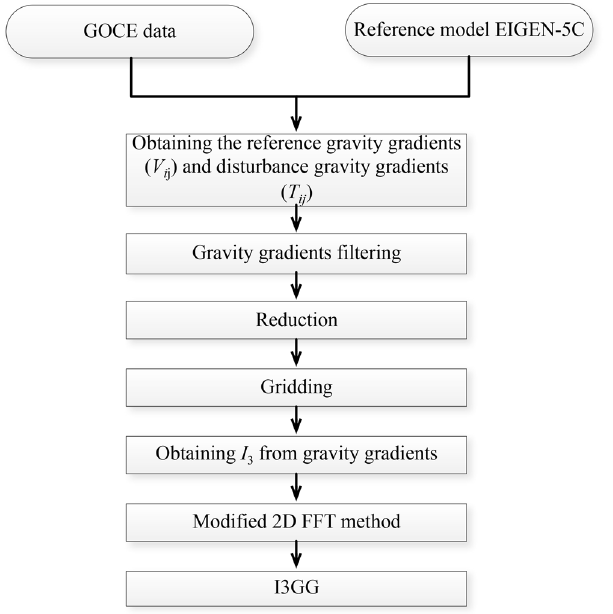
Figure 5. The flow chart of the gravity field determination from the third invariant by the 2D FFT